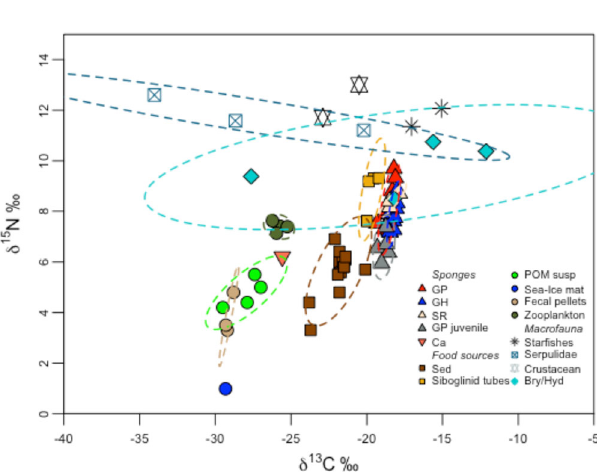
Fig. 4 Bulk stable N and C isotopes of Karasik benthic community. Stable isotope δ 13 C and δ 15 N values ( ‰ ) for sponges, different organic matter sources, and associated macrofauna. Standard ellipse areas (SEAc) depicted by dashed lines provide estimates of the niche area of each of these groups using Bayesian inference as in 106 . For crustaceans, asteroids, sea-ice matter, and calcareous sponge (Ca) the SEAc was not calculated due to limited sample size ( n < 3). Source data are provided as a Source Data fi le. GP G. parva , GH G. hentscheli , SR S. rhaphidiophora , GP juvenile G. parva juvenile, Ca calcareous sponge, sed sediments, POM susp suspended particulate organic matter, Sea-Ice-mat sea-ice matter,